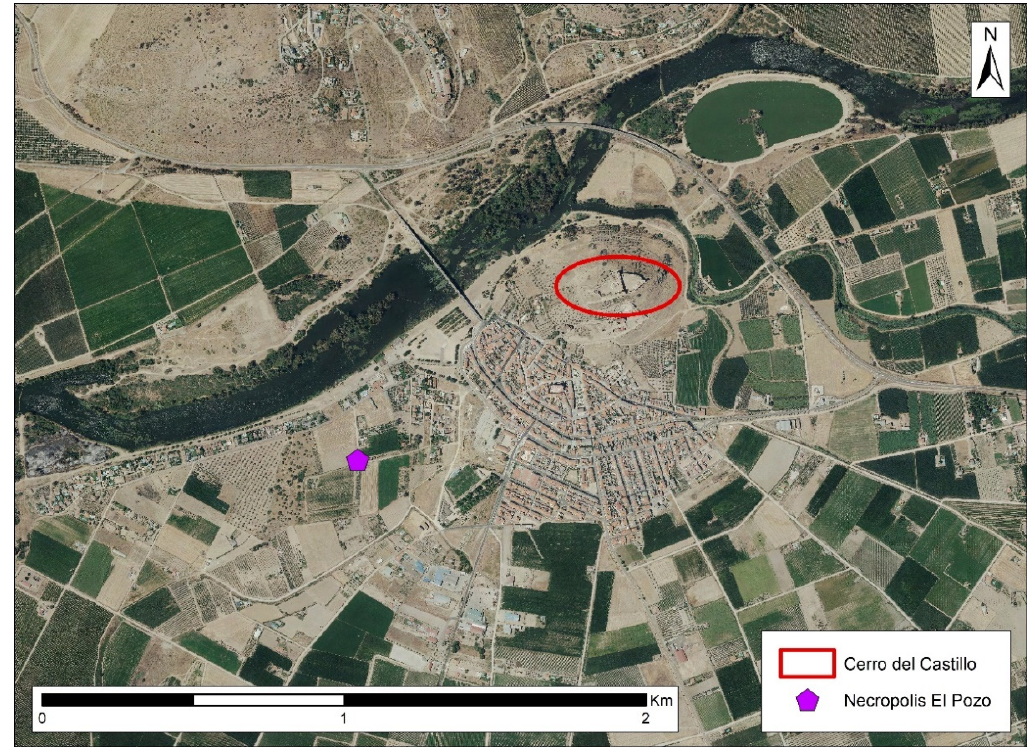
Figure 10. Location of the Cerro del Castillo and the Necropolis of El Pozo (Medellín, Badajoz, Spain).